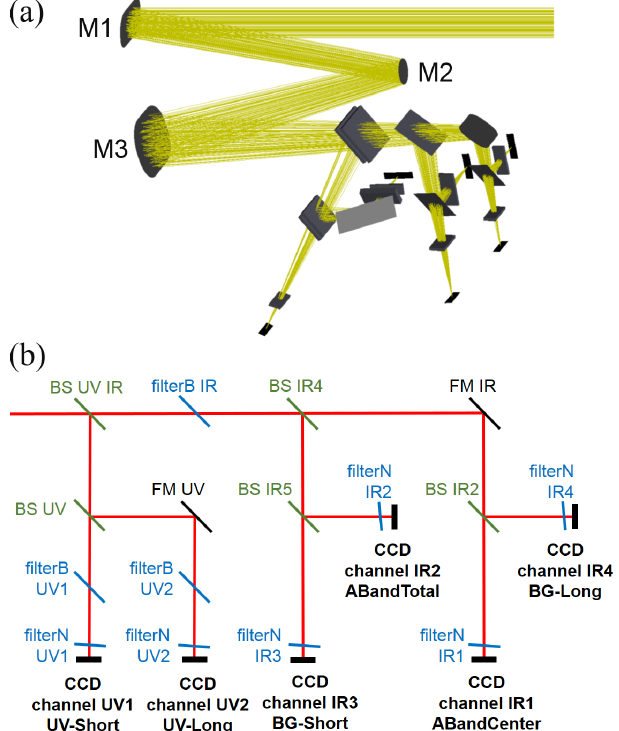
Figure 4. Overview of the optical paths in the limb imager. (a) Ge- ometrical distribution of the optical elements, including the three telescope mirrors M1–M3. (b) Schematic of the channel layout with beamsplitters (BS), broad filters (filterB), narrow filters (filterN), folding mirrors (FM), and CCDs. See also Fig.